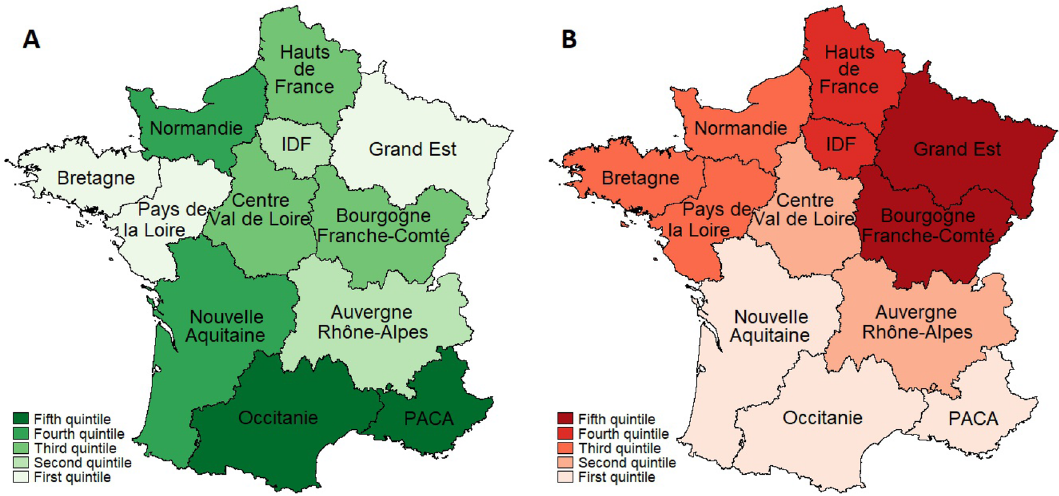
Figure 2. Tests and death rates in metropolitan regions, France, March–May 2020. Panel ( A ): Test rate: number of RT-PCR tests divided by the number of patients admitted to hospitals for COVID-19. Panel ( B ): Death rate: number of deaths in hospitals due to COVID-19 divided by the number of patients admitted to hospitals. We used shapefiles for regions and departments to construct the maps and compute the contiguity matrix. PACA is in the top 20% of regions that test more and in the bottom 20% of regions that have the lowest fatality ratios. Data are freely available at https:// www. sae- diffu sion. sante. gouv.